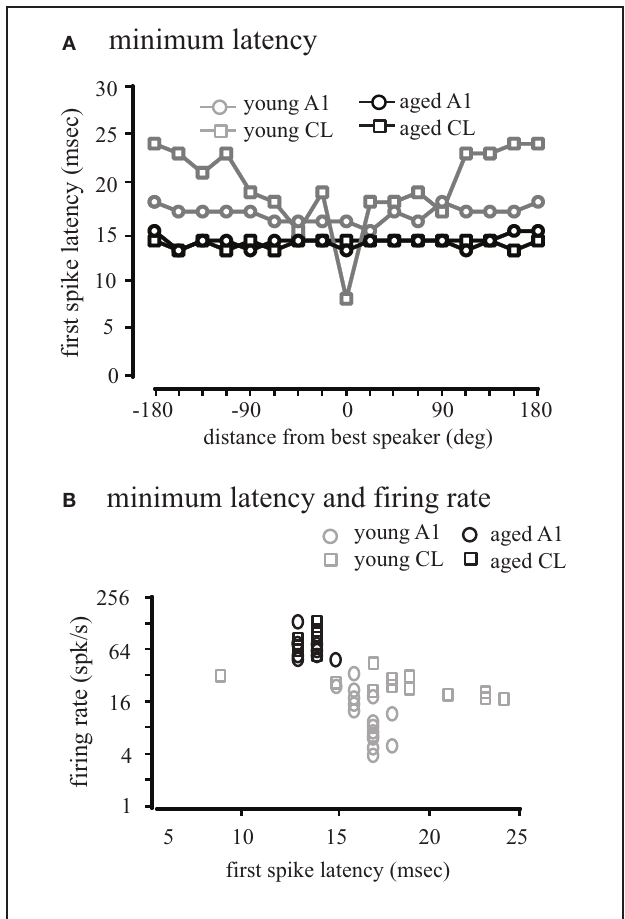
FIGURE 8 | Population first-spike latency. The first-spike latency at each location relative to the best direction is shown for young (gray) and aged (black) monkeys in A1 (circles) and CL (squares) in Panel (A) . Aged monkeys had consistently shorter first-spike latencies than young animals. There was also no difference between A1 and CL in aged monkeys, but in young animals latency increased with distance from the best location. (B) Shows the regression between minimum latency and firing rate. There was a significant increase in latency with a decrease in firing rate in younger animals, but this correlation did not exist in aged